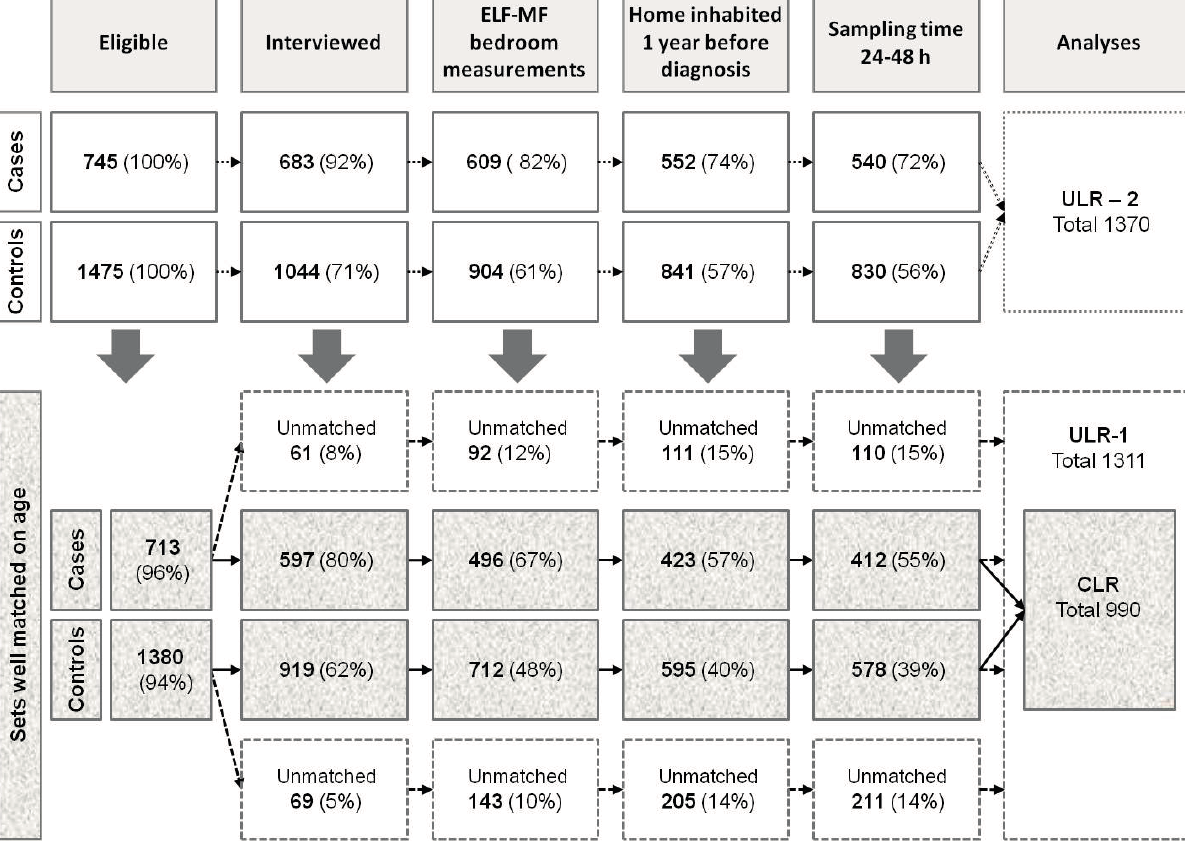
Figure 1. Participation rates and inclusion in the datasets for the analyses. CLR = dataset of cases and controls strictly matched on age (difference in dates of birth not larger than ±15 days), with valid measurements, included in the main analyses based on conditional logistic regression models; ULR-1 = dataset of matched and unmatched cases and controls with valid measurements from sets originally strictly matched on age, included in a first series of unconditional logistic regression models; ULR-2 = dataset of matched and unmatched cases (with valid measurements but independent of compliance with the strict age-matching criterion) included in a second series of unconditional logistic regression models. Participation rates were higher among cases compared to controls. Overall, 92% of case-parents were interviewed vs. 71% of controls. The proportion of eligible children participating in the